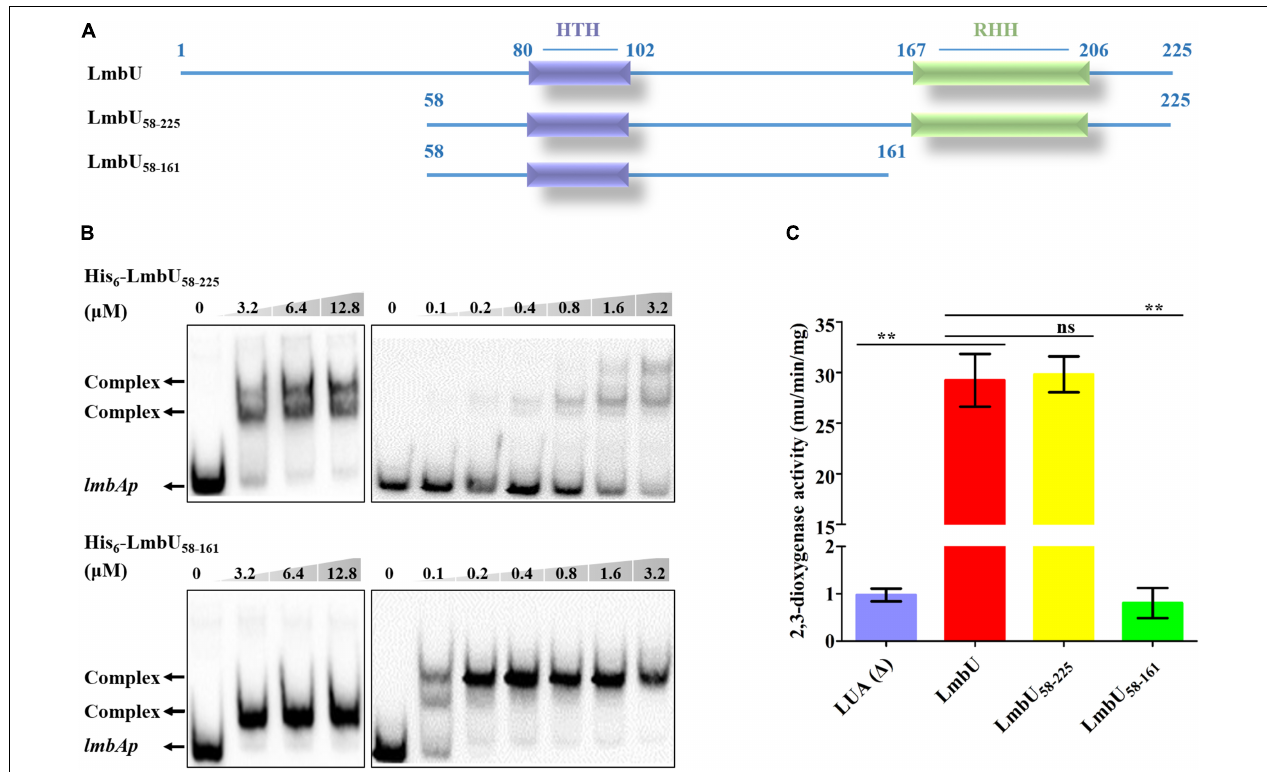
FIGURE 3 | Functional analysis of LmbU variants LmbU 58 - 225 and LmbU 58 - 161 . (A) Sketch map of LmbU protein and LmbU variants. LmbU 58 - 225 contains intact HTH and RHH motifs, LmbU 58 - 225 only contains intact HTH motif. (B) EMSA analysis of LmbU and variants with lmbAp probe. Biotin-labeled lmbAp (263 bp, 5 ng) was incubated with increasing concentrations of His 6 -LmbU 58 - 225 and His 6 -LmbU 58 - 161 , respectively. The DNA-protein complexes and the free probes are indicated by arrows. (C) XylTE reporter assay of LmbU and variants to lmbAp in vivo . Data represent means ± standard deviations of results from three independent experiments. Statistical significance is indicated vs. the results of wild-type LmbU by using T test (Kim, 2015), ns, not significant; ∗∗ P <